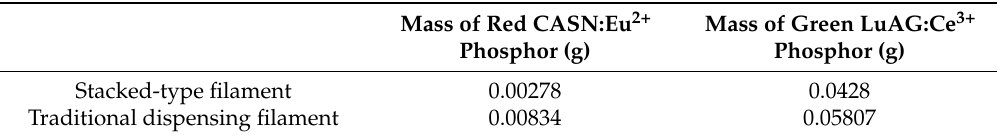
Table 2. Mass of red CASN:Eu 2+ phosphors and green LuAG:Ce 3+ phosphors in each filament with different packaging methods.